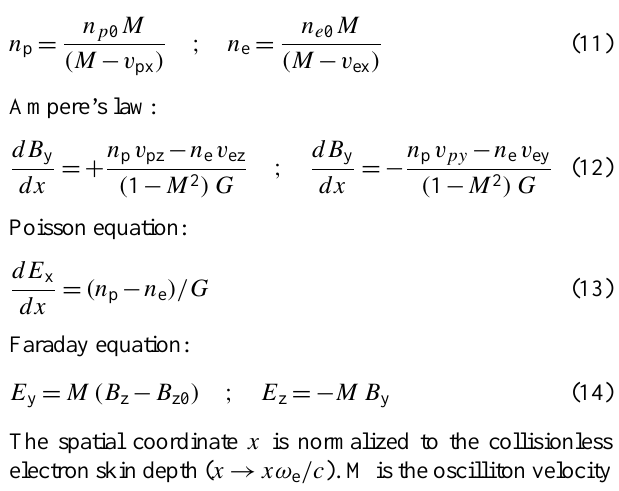
Fig. 5. Spatial profiles of a whistler-Langmuir oscilliton taking G = 5 and θ = 5 ◦ ; from top to bottom: electron density normalized to n eo , x- and y-component of the electric field in units of E 0 = cB 0 and the y-component of the magnetic field normalized to B 0 . The oscilliton velocity was selected as M = U/c = 0 . 9085.